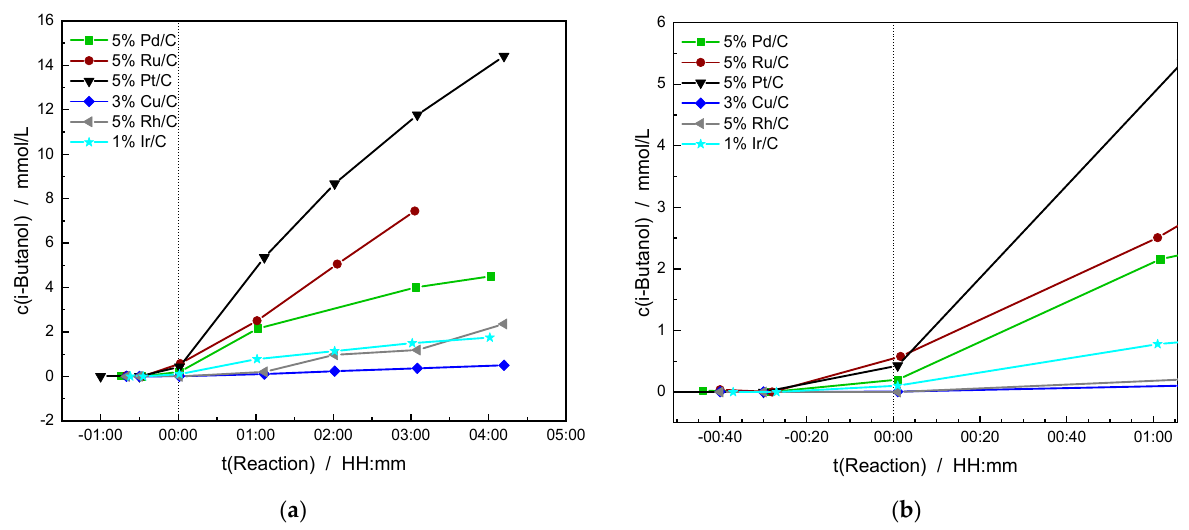
Figure 8. c(i-Butanol) plotted against the reaction time for all catalysts. t(Reaction) = 4 h, T = 150 ◦ C, N = 1000 RPM, V = 70 mL, and m(catalyst) = 0.1 g. ( a ) Overview of the entire reaction time and ( b ) enlarged for the heating-up period. The dotted line marks the point at which 150 ◦ C was